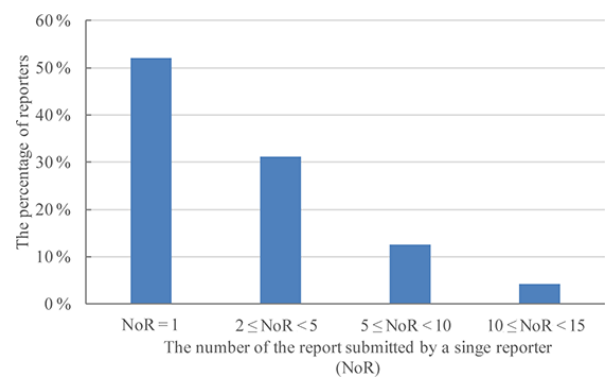
Figure 10. Distribution of reports versus